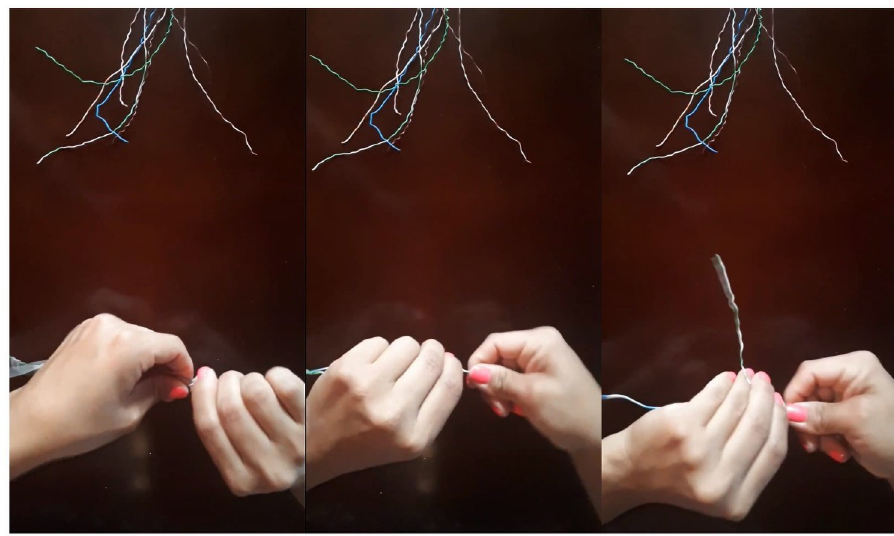
Fig 1. Steps of activity that participants have carried out. The process consisted of winding cables without stopping for 10 minutes.